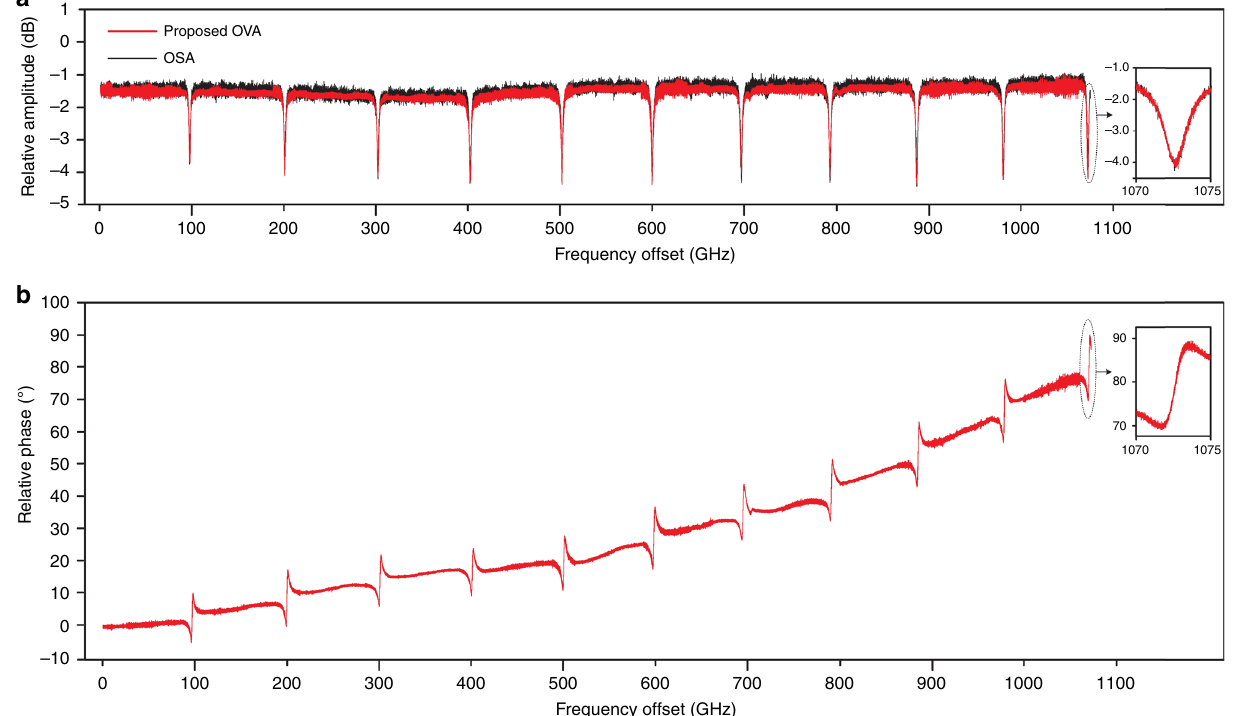
Fig. 4 The spectral responses of a H 13 C 14 N gas cell measured by the proposed OVA. a The magnitude responses are measured by the proposed method (red line) and an OSA (black line). b Since the OSA cannot measure the phase of the optical signal, the phase response can only be obtained by the proposed OVA